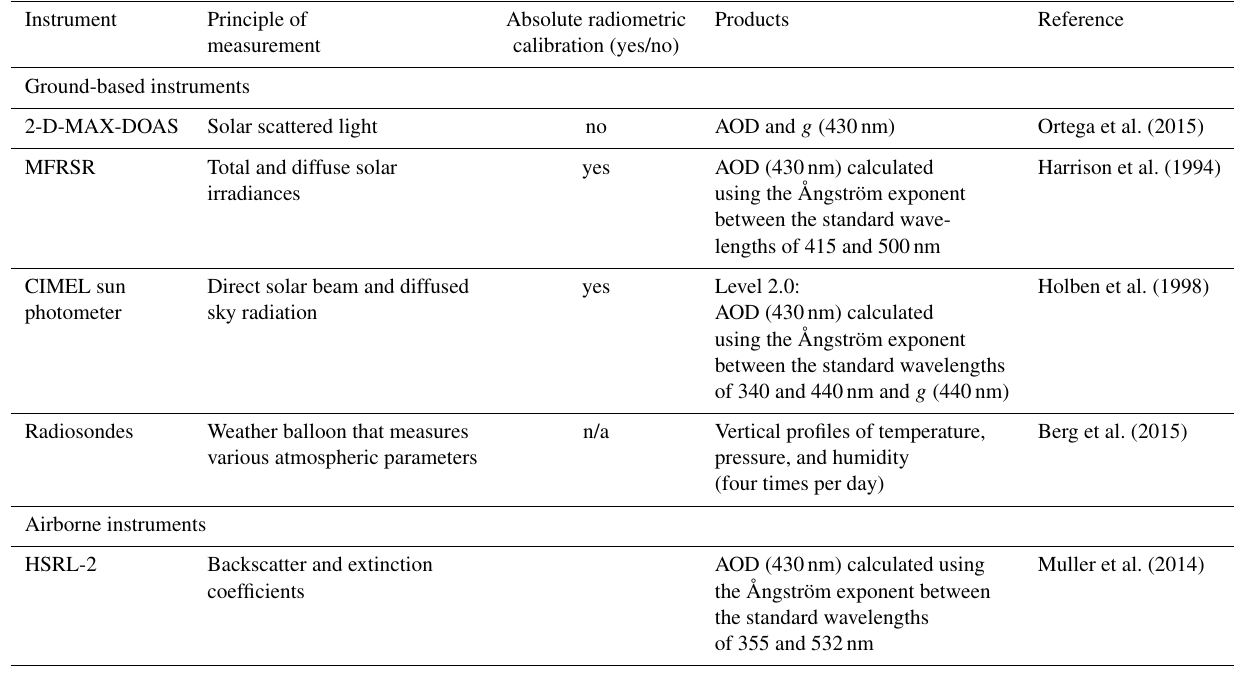
Table 1. Suite of measurements and products used in this work.